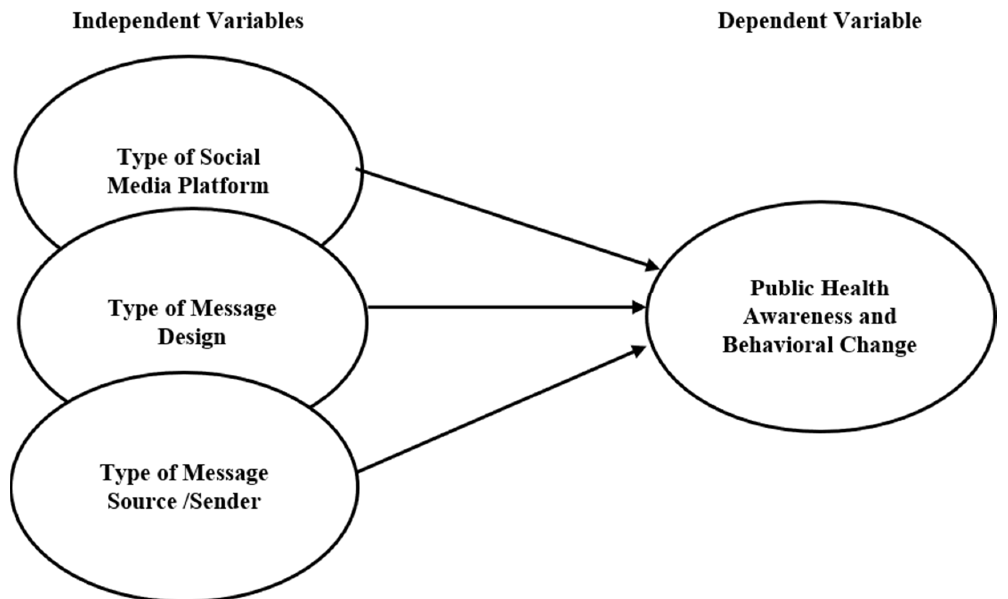
Figure 1. The study model.